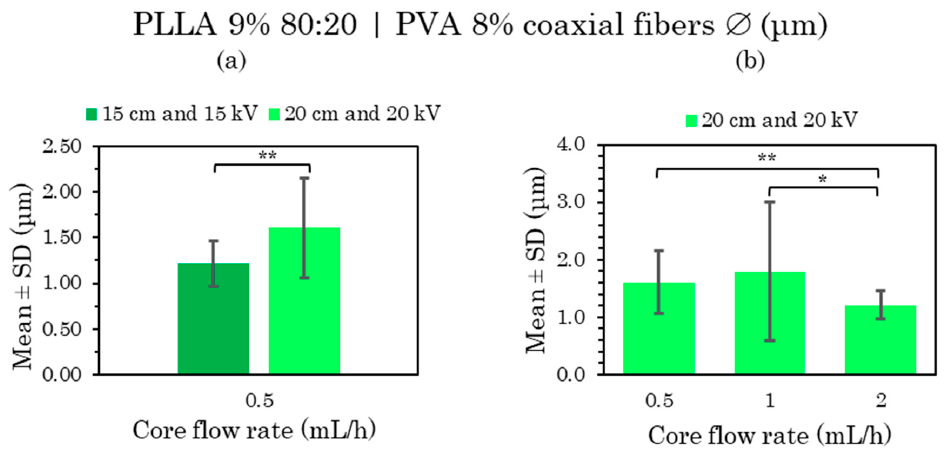
Figure 8. Mean and standard deviation of the diameters of 9% PLLA 80:20 (shell) and 8% PVA (core) coaxial microfibers manufactured at 0.5 mL/h with 20 cm and 20 kV compared with 15 cm and 15 kV ( a ), and at 0.5, 1 and 2 mL/h with 20 cm and 20 kV ( b ). Shell flow rate 4 mL/h in both cases, at (*) p < 0.05, (**) p < 0.01 statistically significant differences.